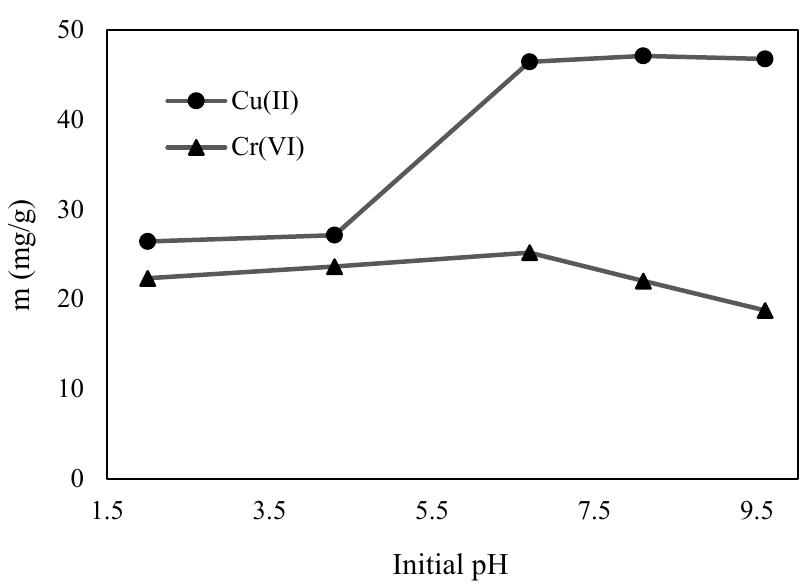
Figure 3. Effect of initial pH on Cu(II) and Cr(VI) adsorption. (C-ZLCH: 0.01 g, initial metal ion: 10 mg/L, volume (mL): 50, temperature: 30 °C, and time: 30 min).